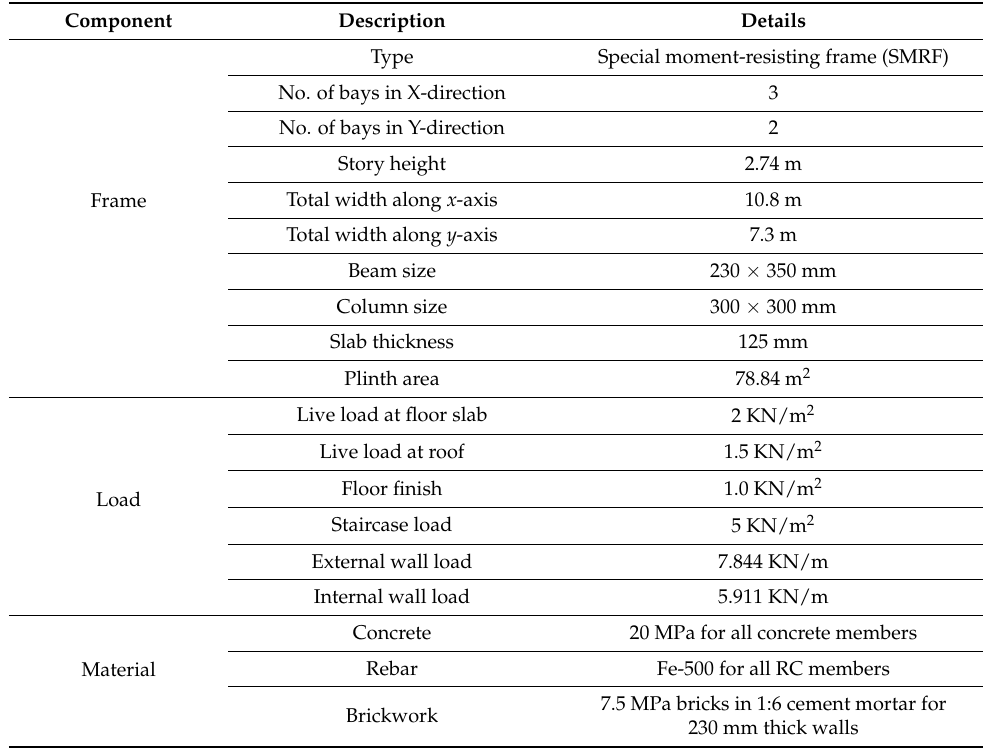
Table 1. Structural and material characteristics of a representative MRT building in